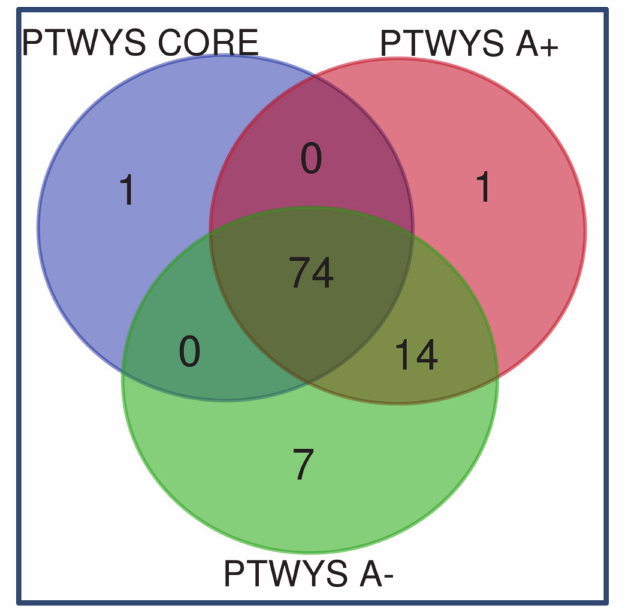
Figure 11. Venn diagram representation of pathways classified in the CORE, A+, and A- zones of R